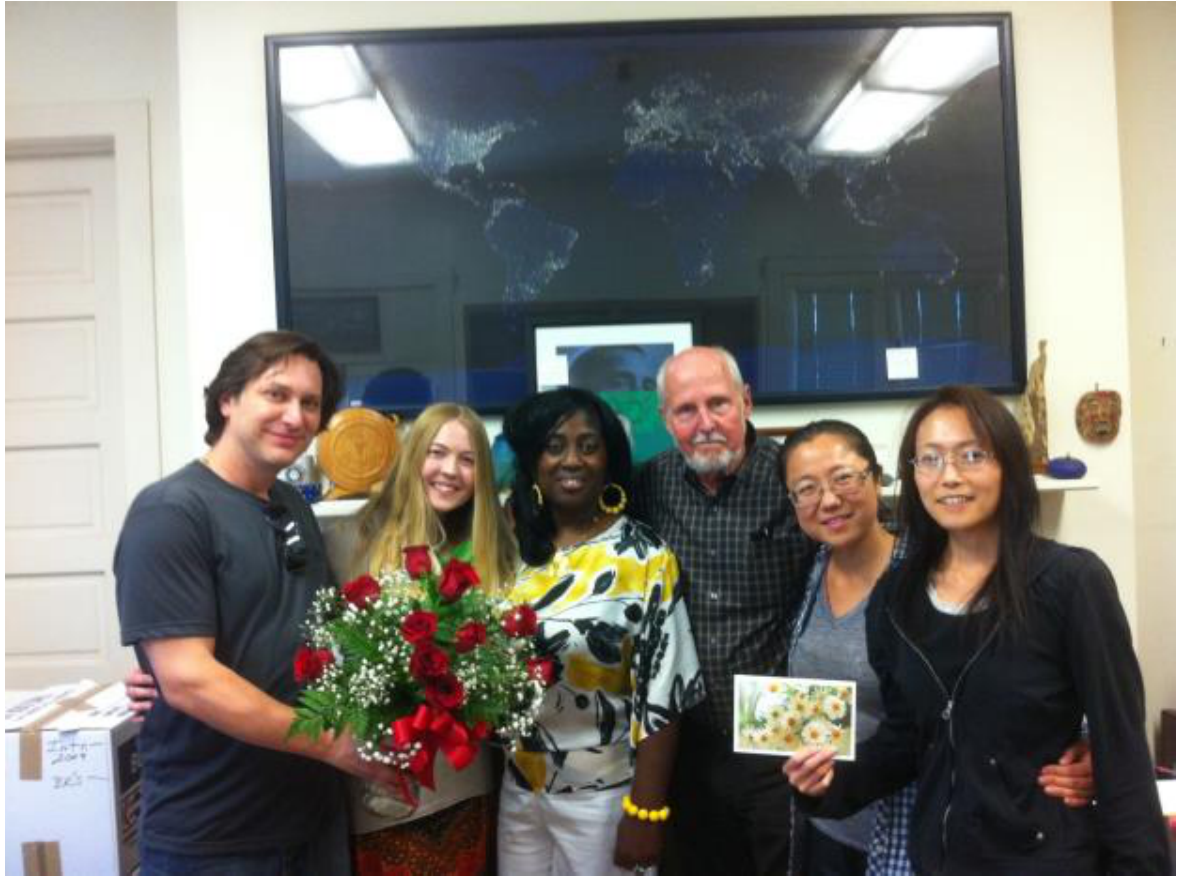
Gender, Tunisia, the Arab Spring and the World Revolution of